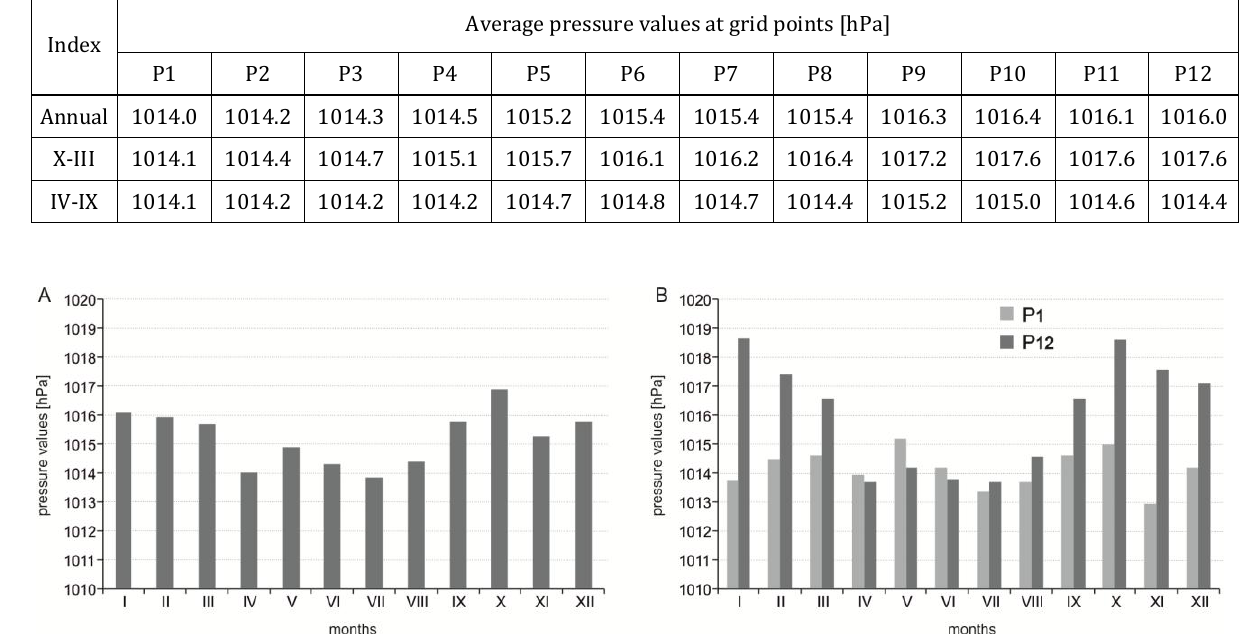
Fig. 2. Average monthly pressure values for 12 (A) and at selected (B) grid points in the period